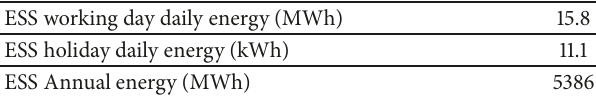
Table 3: ESS energy